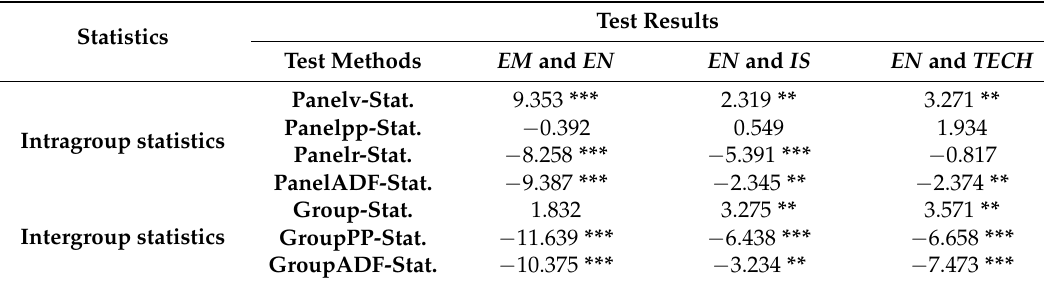
Table 2. The results of the cointegration test.